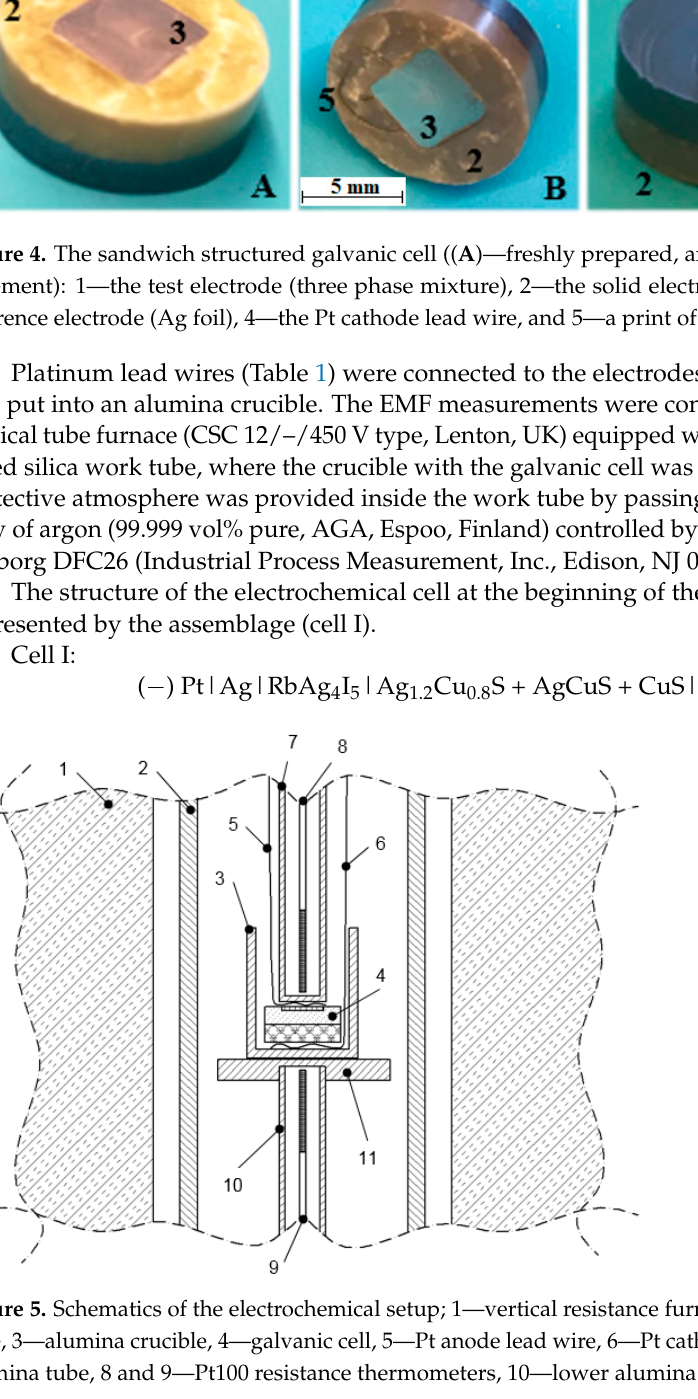
Figure 3. A portion of isothermal phase diagram of the ternary Ag-Cu-S system, below 363 K (illus- trated based on the information provided in [4]). Notations: S2 is Ag 0 . 93 Cu 1 . 07 S (ortho), S3 is